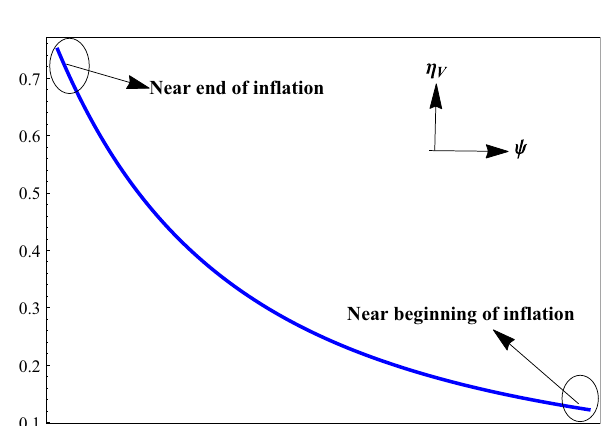
Fig. 3 η V vs. (cid:13)